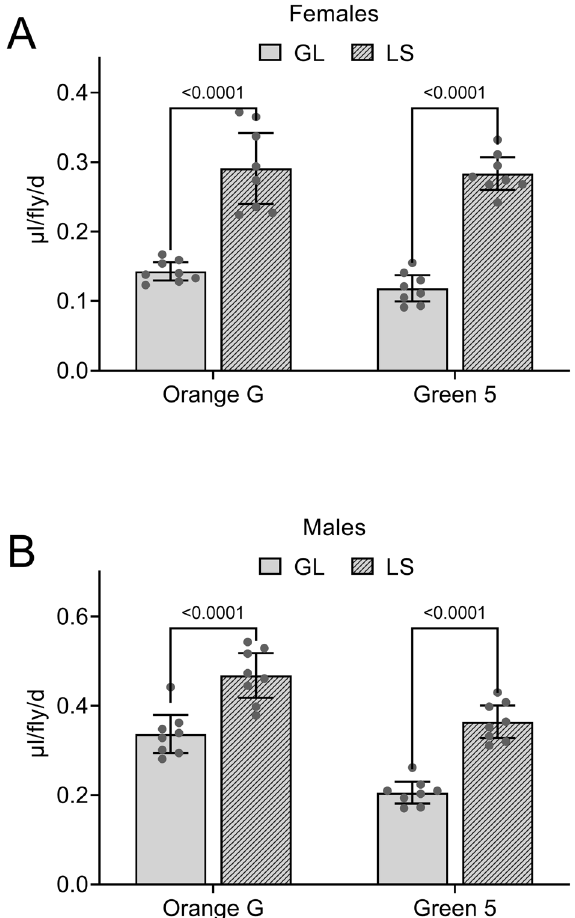
Figure 3. Effect of strain on Con-Ex determined with Orange G and Green 5. Flies consumed-excreted 2Y10S3C media with the indicated dyes for 24 h. ( A ) In GL and LS females, Con-Ex was significantly affected by strain, but not dye (two-way ANOVA; sex, p < 0.0001; dye, p = 0.2249; interaction, p = 0.5166; n = 8). ( B ) In GL males, Con-Ex was affected by strain and dye (two-way ANOVA; sex, p < 0.0001; dye, p < 0.0001; interaction, p = 0.4206; n = 8). Con-Ex was greater in LS compared to GL flies in all cases (Bonferroni’s, p values shown for pair-wise